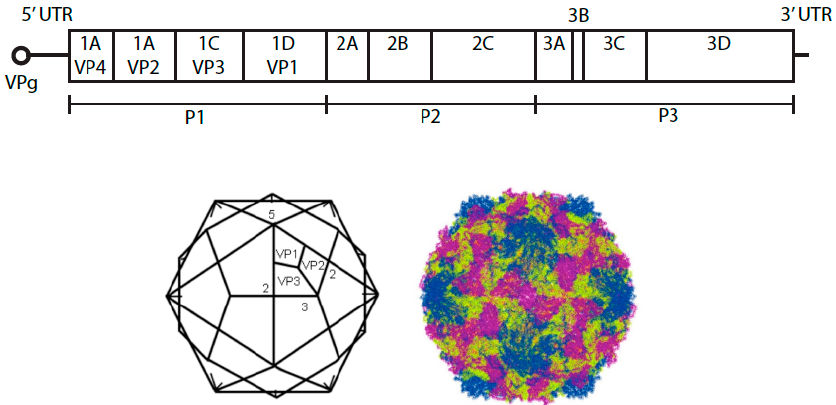
Figure 1. Schematic representation of the genome of an enterovirus B species. Below is the representation of the icosahedron structure of E1 showing the locations of two-, three-, and five-fold axes of symmetry and VP1 to VP3. The structure of E1 on the right was created using Jmol version 12.0.41 (an open-source Java viewer for chemical structures in 3D.) and the atomic coordinates downloaded from the Protein Data Bank, Brookhaven National Laboratory.